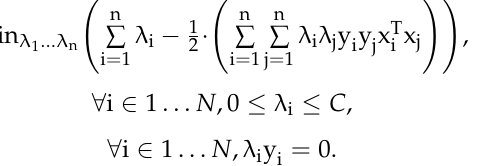
methods (for example,